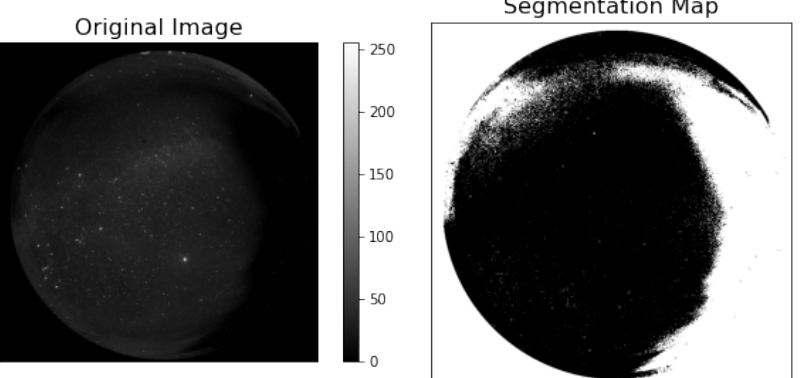
Figure 4. An example of the derived cloud segmentation map based on the Otsu method. Original moonless image ( left ); the black color represents the regions covered by clouds. Segmentation map ( right ); the regions covered by clouds are indicated in white